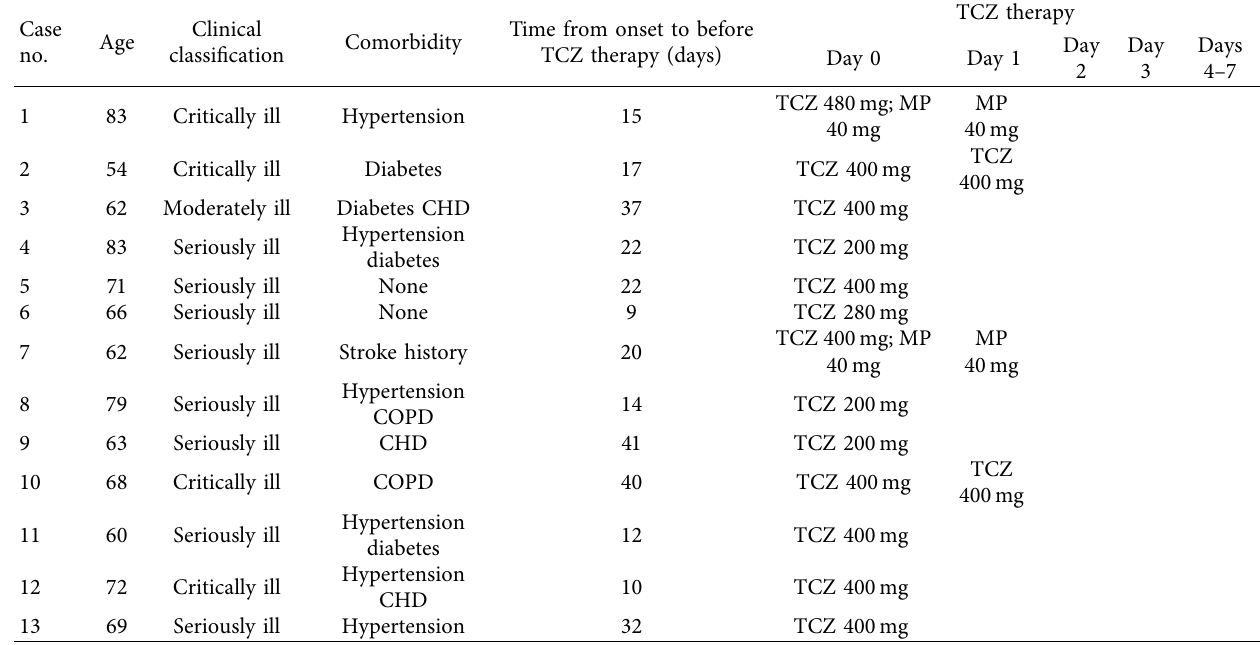
Table 1: The clinical characteristics of COVID-19 patients treated with TCZ.